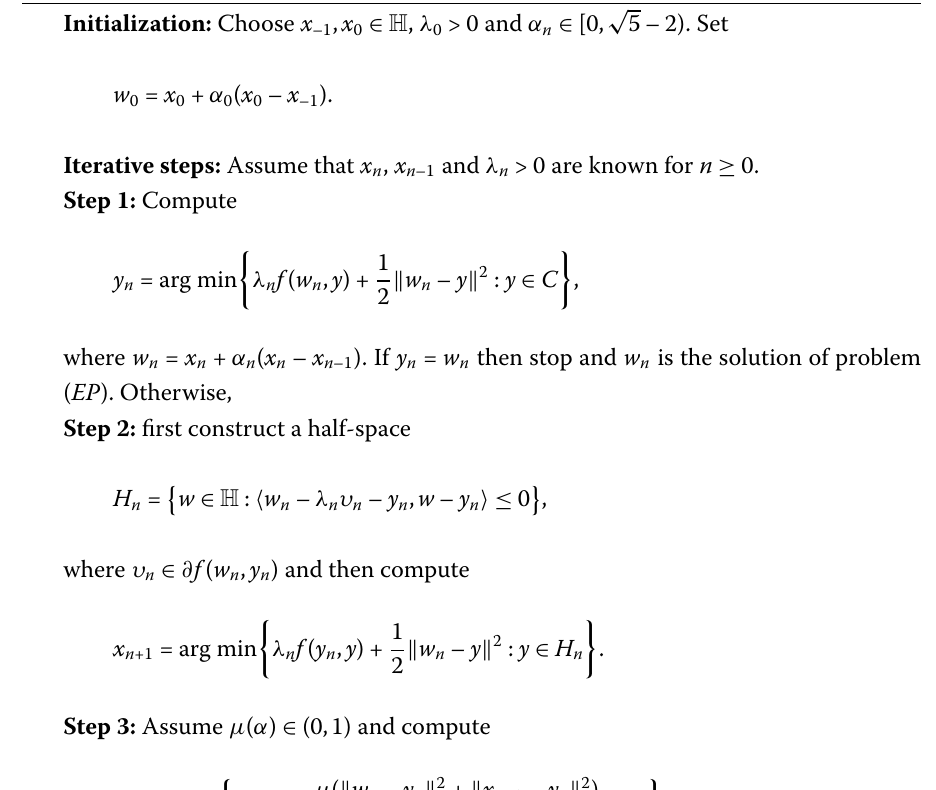
Algorithm 2 Modified subgradient explicit iterative algorithm for pseudomontone